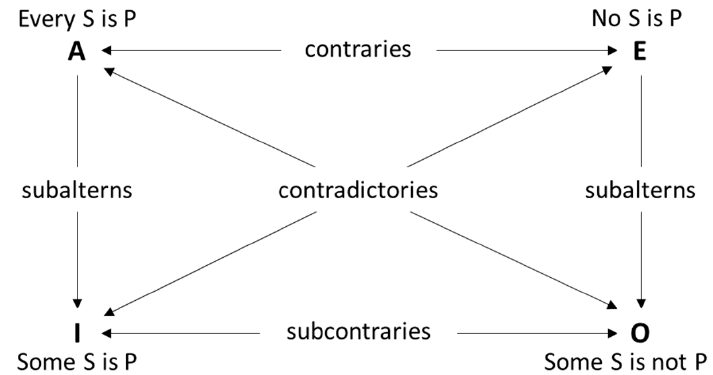
Figure 2. Square of opposition.